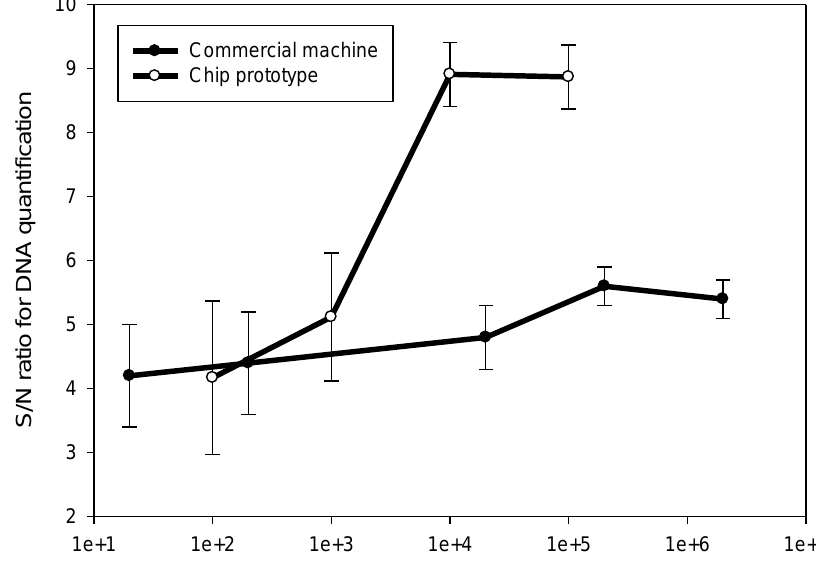
Figure 9. S/N ratios of the commercial machine and the chip for samples of serial concentration levels from 10 6 to 10 copies per reaction. The comparison is used to verify performance of the real-time PCR chip system and the results show that the chip does not work as well as the machine for analyzing the sample that contains lower initial copy numbers than 10 3 copies per